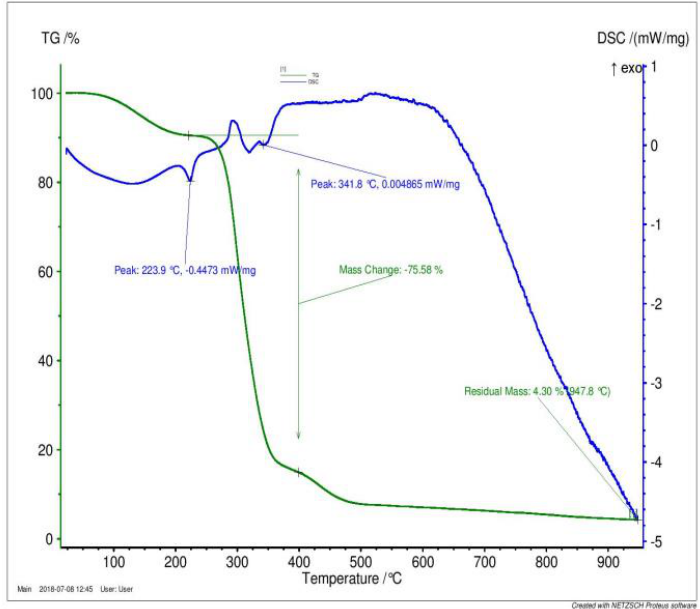
Figure 10. TGA and DSC curve of nanocellulose PVA composites.